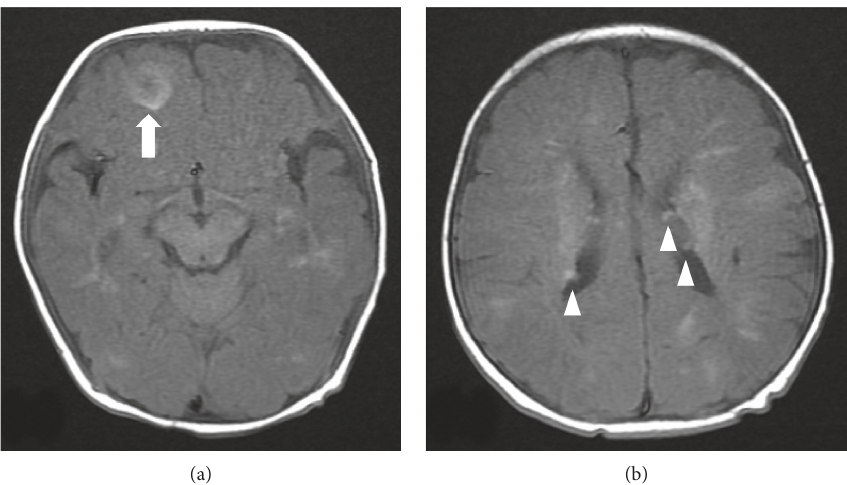
Figure 2: At 3 months of age, T1-weighted magnetic resonance imaging showed a right frontal cortical tuber (arrow) (a) and high signal intensity lesions in both cerebral hemispheres, with multiple nodular lesions (arrowheads) along the lateral ventricular caudothalamic grooves (b).